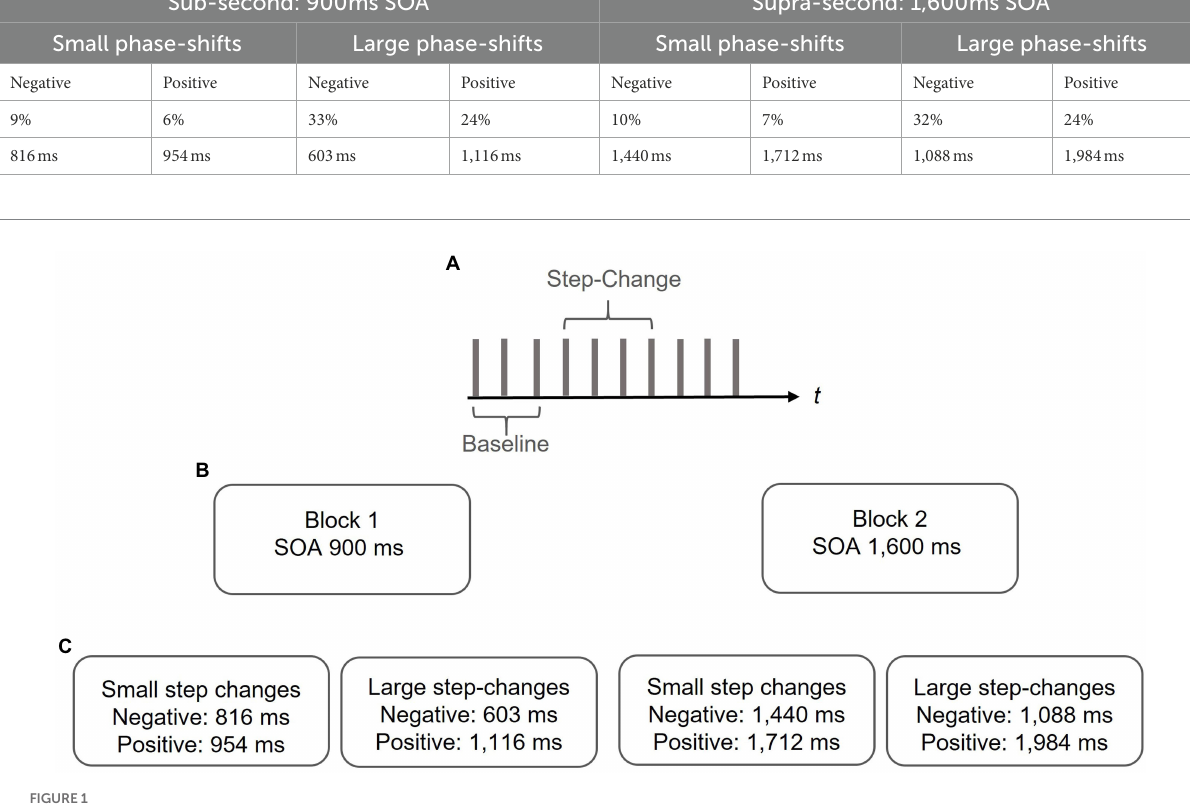
FIGURE 1 Paradigm. (A) In a series of 10 pacing signals a step-change was randomly interspersed between the 4th and 7th pacing signal. The 3 taps preceding the step-change served as a measure of baseline synchronization performance. (B) In two separate blocks baseline SOAs of either 900 or 1,600 ms were adopted. (C) Step-changes were either positive or negative and either small (i.e., non-perceivable) or large (i.e., perceivable). Data from a pilot study suggest asymmetrical detection thresholds with smaller deviations being detected in positive as compared to negative deviations. Step-changes were adapted with respect to those